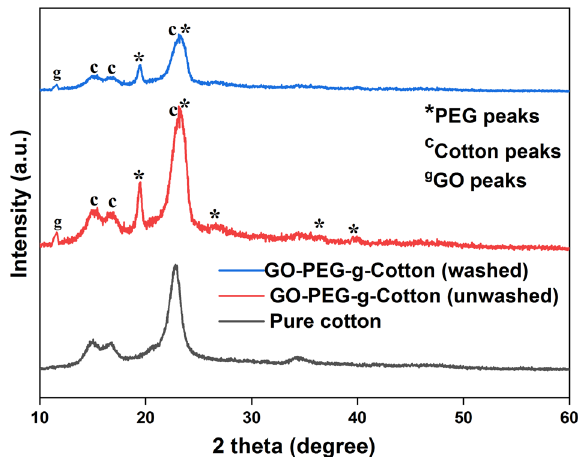
Figure 4. XRD plot of pure cotton and